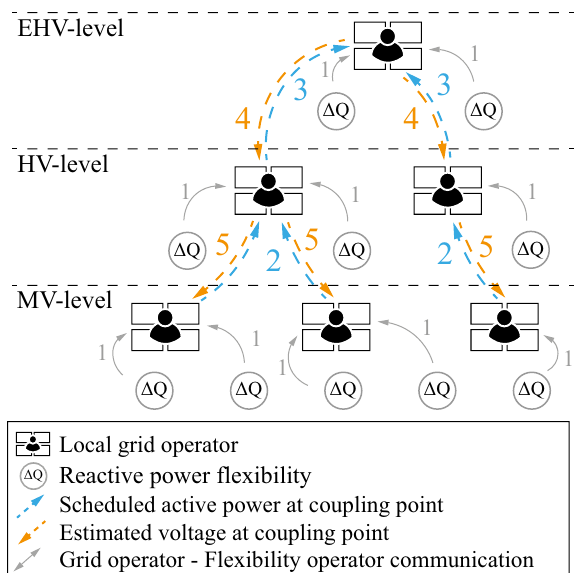
Fig. 9 Market extension: Additional information exchange in the case without on-load tap-changing transformers